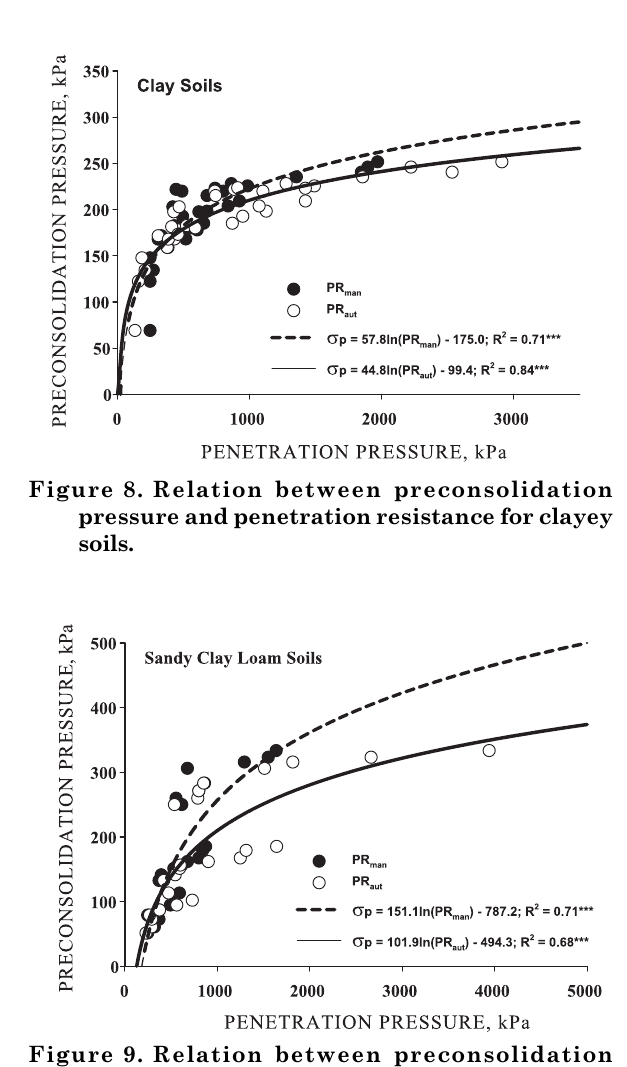
Figure 7. Relation between preconsolidation pressure and penetration resistance including clayey and sandy soils.